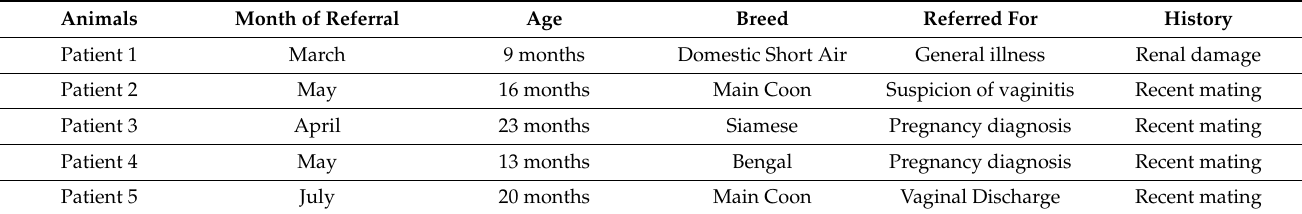
Table 1. Signalment and history of animals included in the case